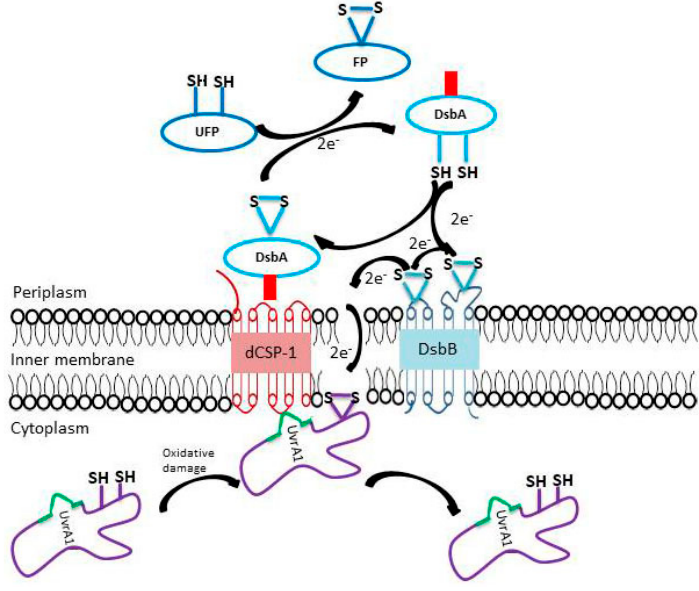
Figure 9. Proposed model to account for the novel genomic-proteomic characteristics of the UvrA1 gene/protein from Deinococcus species and their possible roles in protection of this protein from oxidatively generated damage. The model shown here proposes that the 5–7 amino acid insert present specifically in the Deinococcus DsbA protein (shown in red) plays a role in its interaction with the membrane embedded Deinococcus -specific protein dCSP-1. The model also suggests that the 30 amino acids insert found uniquely in Deinococcus UvrA1 homologs allows specific interaction with the dCSP-1 protein. These interactions position the UvrA1 protein in the proximity of cytoplasmic membrane such that the CXXC motifs in UvrA1 can receive electrons from DsbB protein to reduce oxidized cysteines and regenerate the functional non-oxidized form of the UvrA1 protein. The arrows indicate the direction of electron flow from DsbA to DsbB and to the membrane-associated UvrA1 protein. FP and UFP refer to folded and unfolded